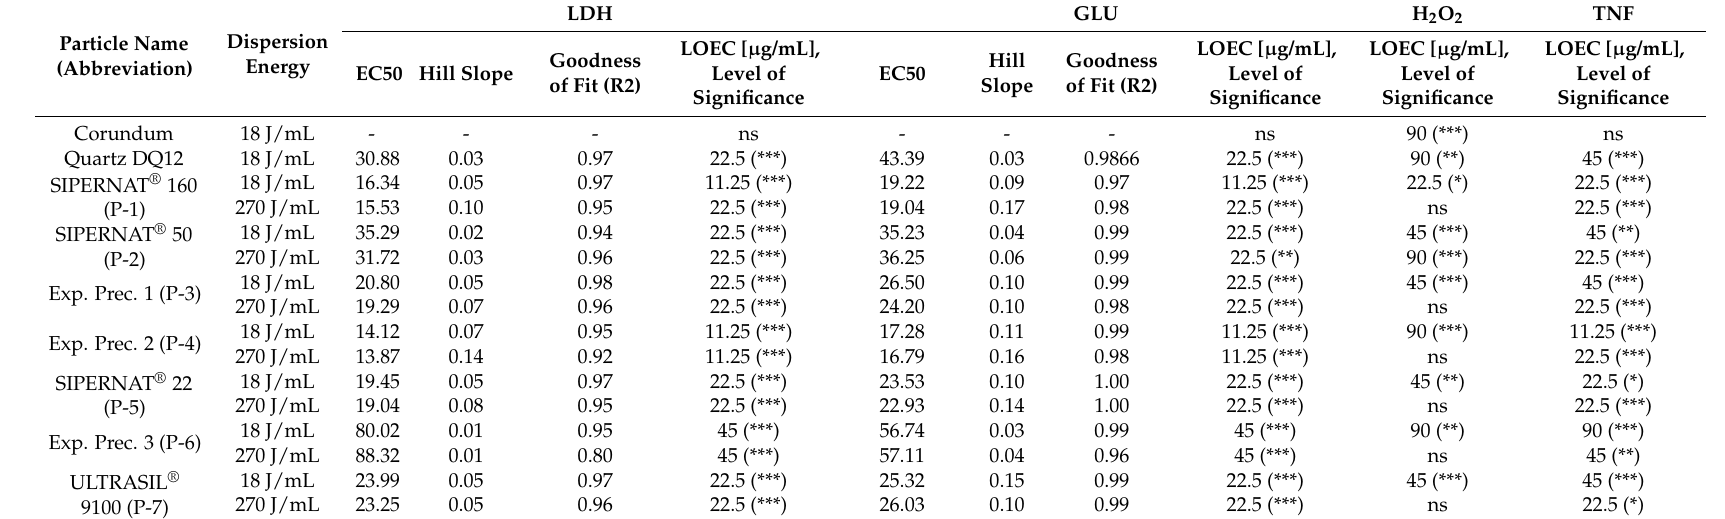
Table 3. Evaluation and curve statistics for precipitated